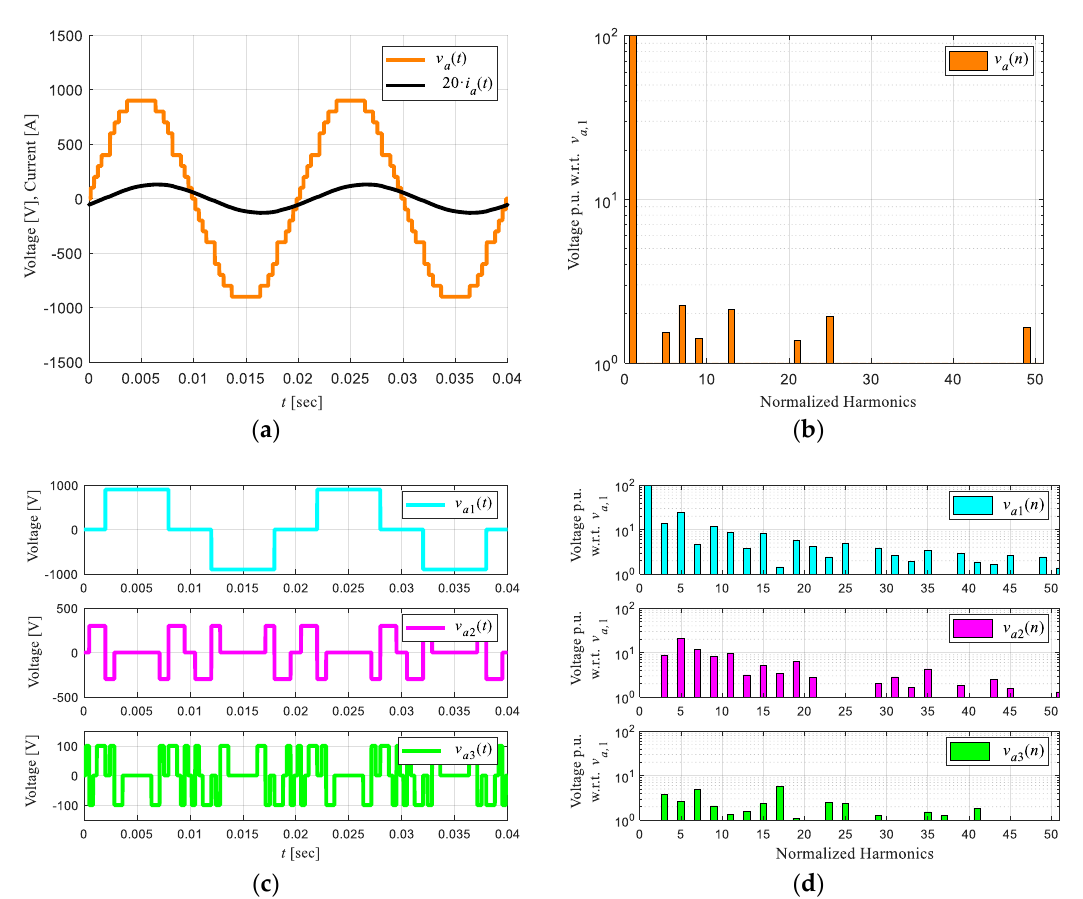
Figure 9. Simulation results 27 levels single-phase asymmetric Inverter without regeneration for m = 0.7. ( a ) Output voltage and current, ( b ) Harmonic spectrum for output voltage v a ( t ), ( c ) Individual inverter output voltages, ( d ) Harmonic spectrum v a 1 ( n ), v a 2 ( n ), and v a 3 ( n ).